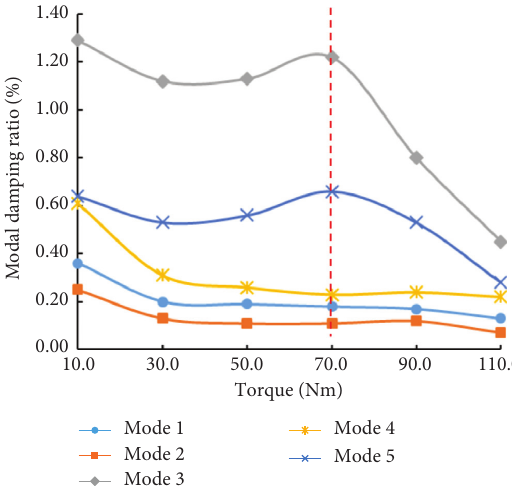
Figure 8: Modal damping versus preload from 10 to